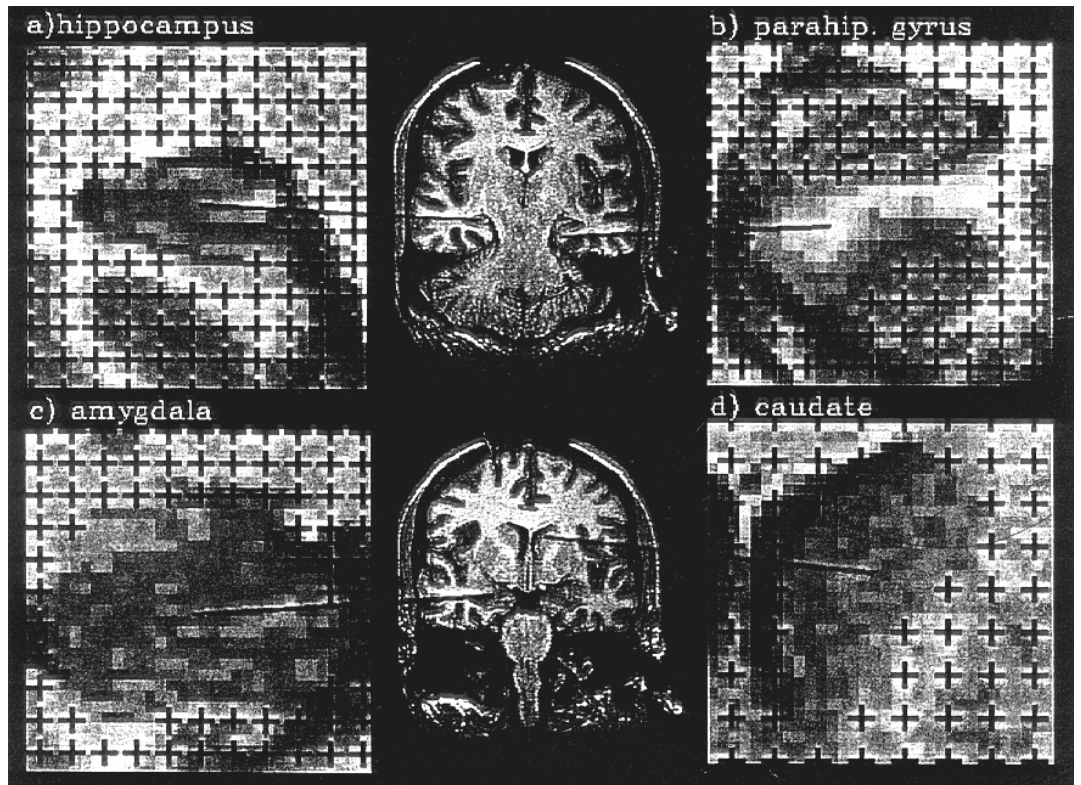
Fig. 2. MR images reformatted perpendicular to the long axis of the hippocampus (see Fig.1) overlain by test system to illustrate estimation of the section areas of the hippocampus, parahippocampal gyrus, caudate, and amygdala by point counting. Points overlying the structure of interest have been